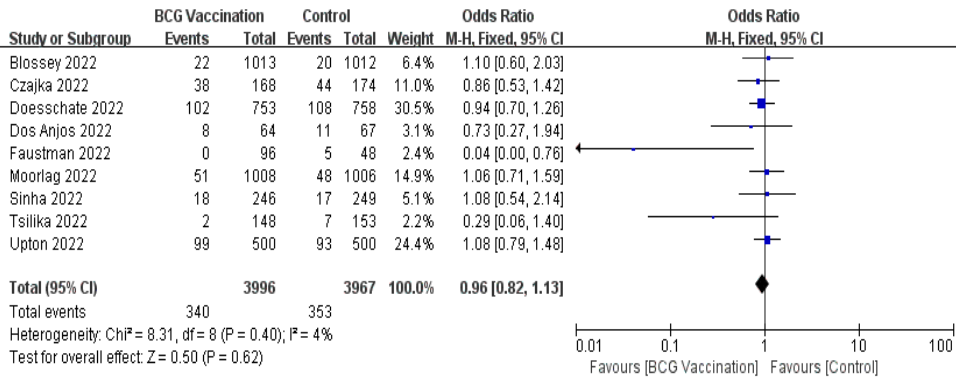
Figure 2. Forrest plot of the odds ratio of the incidence of COVID-19 between the BCG vaccination group and the control group.